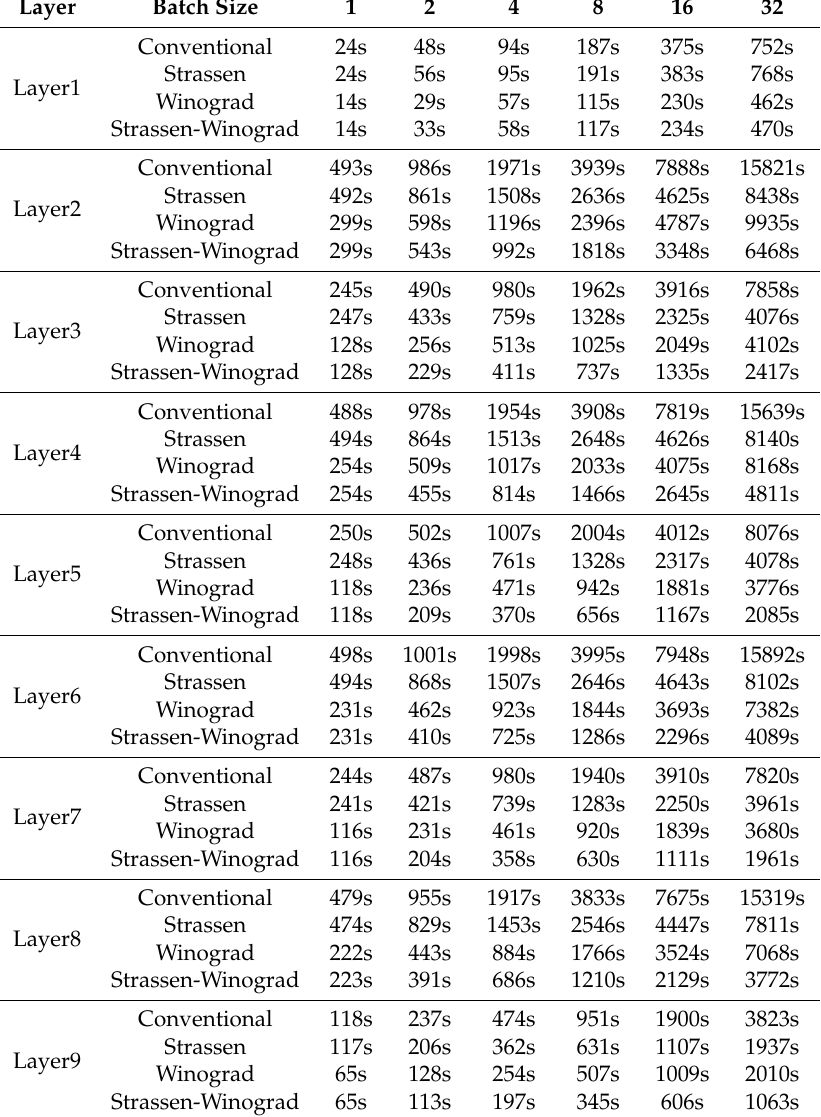
Table 3. Runtime consumption of different algorithms.